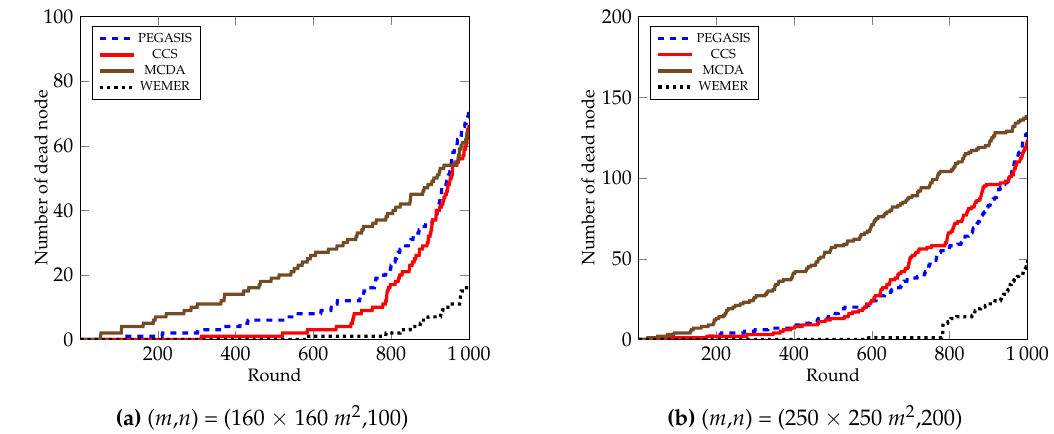
Figure 15. Number of alive nodes over round.